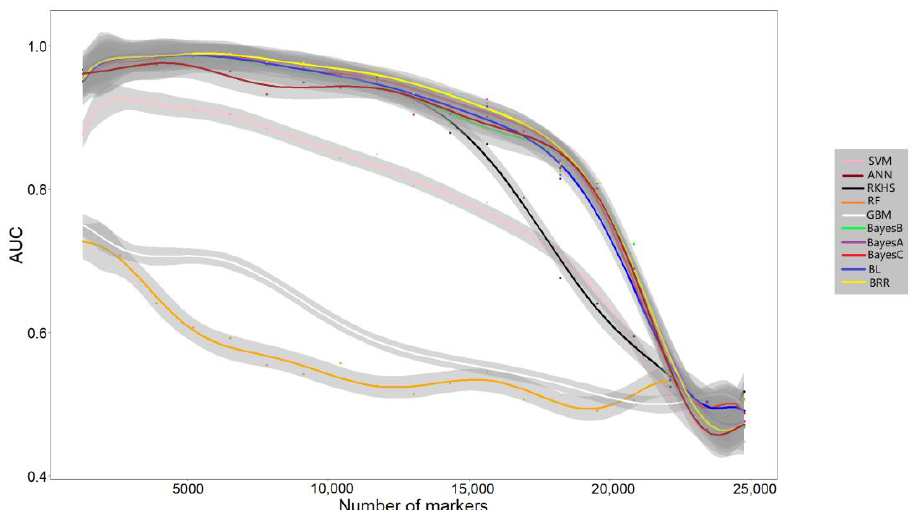
Figure 3. Prediction efficiency of each algorithm when using GWAS to select subsets of significant SNPs. The dataset of C. gigas was used. The number of markers used and the prediction efficiency evaluated by AUC (area under the curve) are represented in the X and Y axes, respectively. The grey area indicates 90% confidence interval.